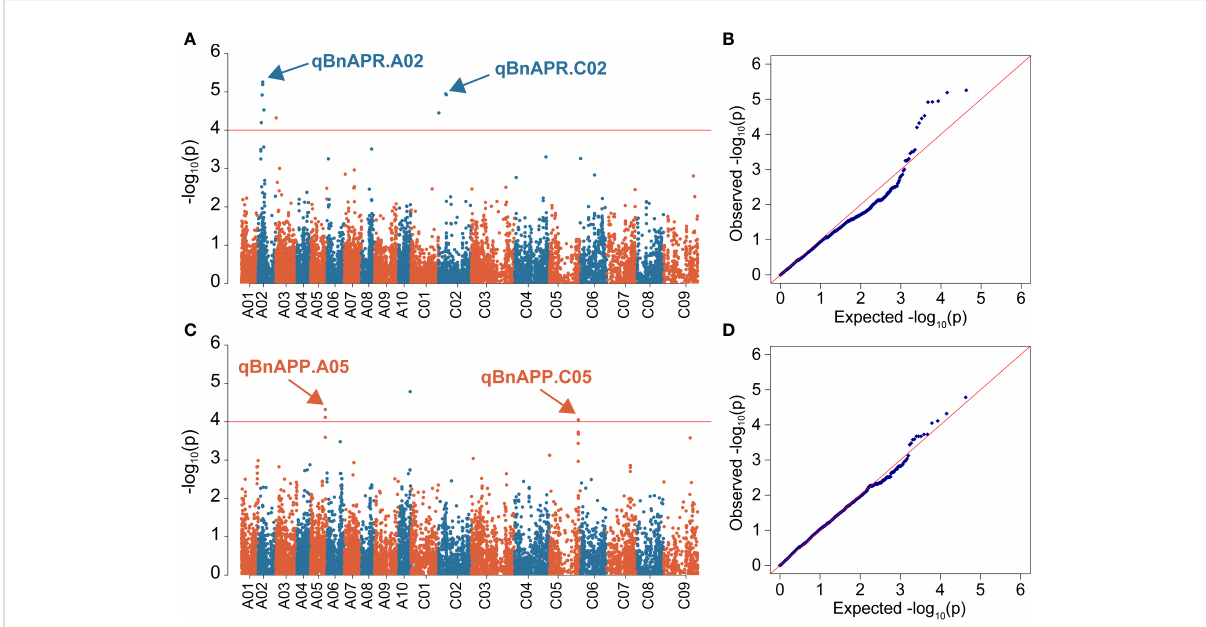
FIGURE 4 Manhattan and quantile-quantile (QQ) plots showing associations between SNPs and two pod orientation traits in 136 rapeseed accessions. GWAS was conducted by the mixed linear model (MLM) in Tassel v5.0. (A) Manhattan plot for the angle of pedicel to raceme (APR) across three environments; (B) Q-Q plot for the APR across three environments; (C) Manhattan plot for the angle of the pod to pedicel (APP); (D) Q-Q plot for APP. The horizontal red line represents the genome-wide signi fi cant threshold ( p =1.0 × 10 -4 ) For clarity, only SNPs with a − log 10 P-value >=4 are shown. SNPs are plotted according to their physical positions on the ZS11 reference